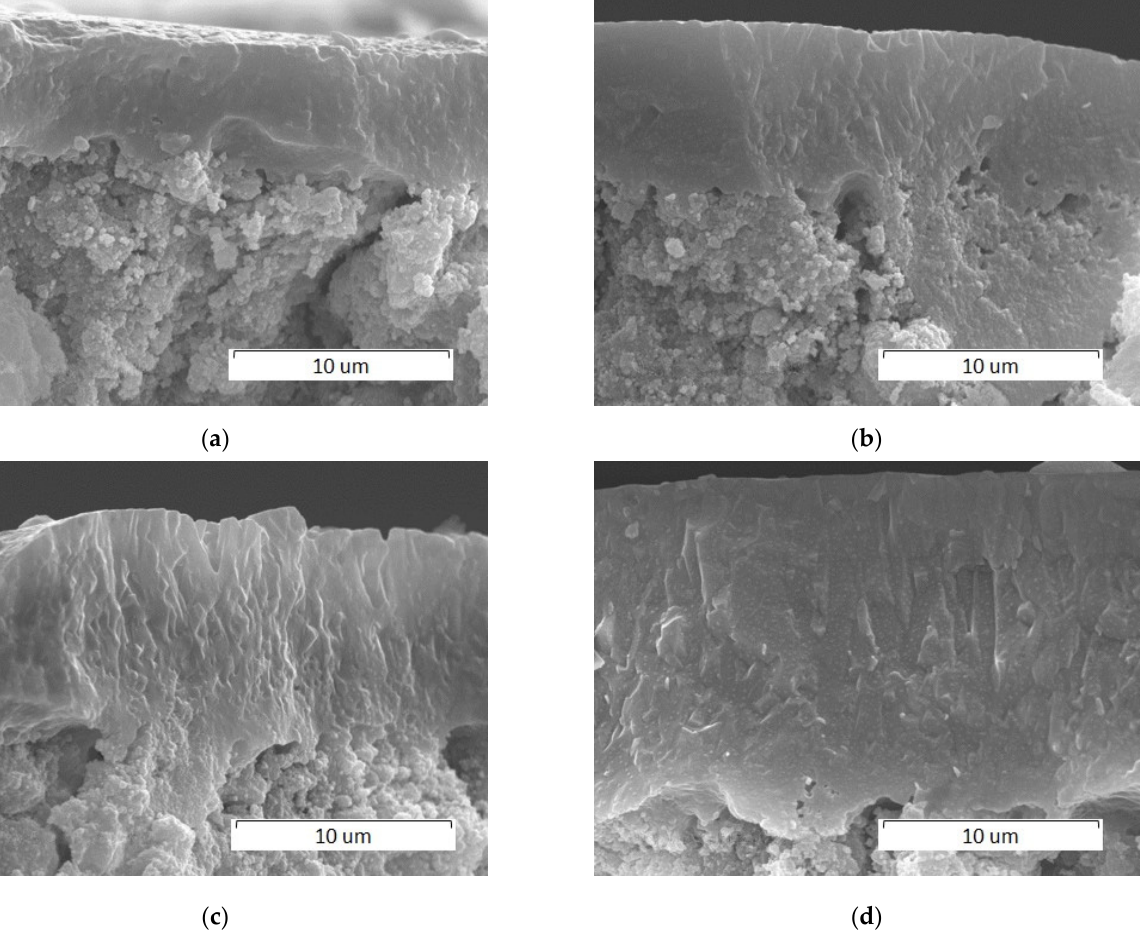
Figure 10. SEM images of cross sections of pellets treated by a 0.2 mm laser spot at 4 W and different scanning speeds, mm/s: ( a ) 700; ( b ) 500; ( c ) 300; and ( d ) 200.